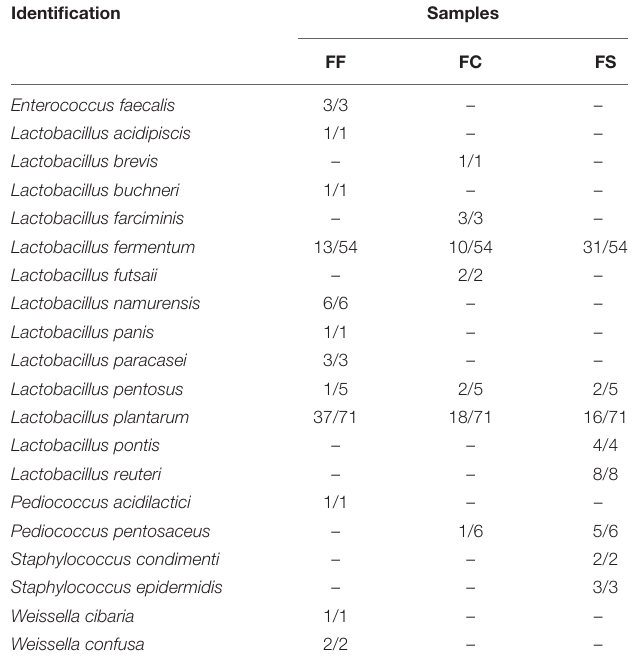
TABLE 3 | 16S rDNA identification of bacteria in fermented